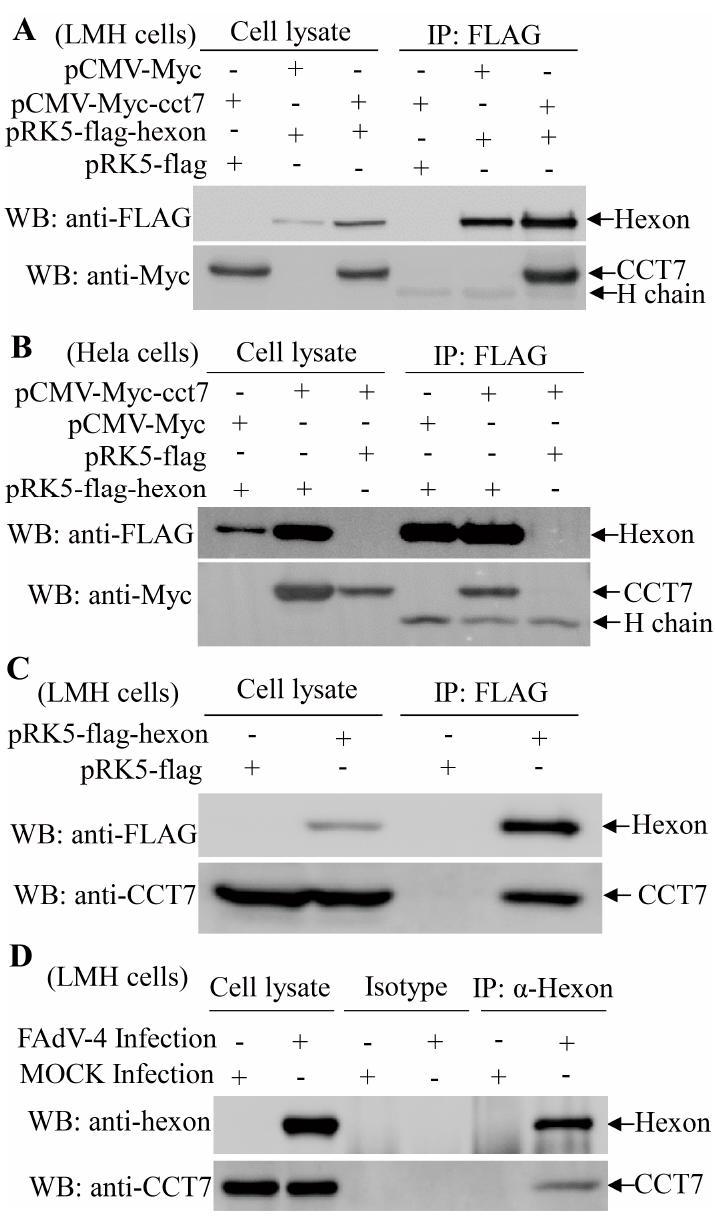
Figure 3. Interaction of FAdV-4 hexon with cellular protein CCT7. ( A , B ) The interaction of hexon with exogenous CCT7. LMH cells ( A ) and HeLa cells ( B ) were transfected with the indicated expression plasmids and immunoprecipitated (IP) with anti-FLAG antibodies. Hexon and CCT7 in the immune complex were examined with Western Blot using anti-FLAG and anti-Myc McAbs, respectively in the cell lysates and in the immunoprecipitates too. ( C ) The interaction of hexon with endogenous CCT7 in LMH cells. LMH cells were transfected with pRK5-FLAG-hexon or empty vector as control. Twenty-four hours after transfection, cell lysates were prepared and immunoprecipitated with anti-FLAG antibody. Both the cell lysates and the immunoprecipitates were immunoblotted with anti-FLAG or anti-CCT7 antibodies. ( D ) Interaction of hexon with endogenous CCT7 in FAdV-4-infected cells. LMH cells were mock infected or infected with FAdV-4 at an MOI of 1, and immunoprecipitation assays were performed with an anti-hexon McAb. CCT7 in the immune complex was examined with Western Blot using anti-CCT7 polyclonal antibodies. The “H chain” means the heavy chain of the antibody. The “isotype” means isotype (IgG2b) control antibody of anti-FAdV-4 hexon monoclonal antibody.